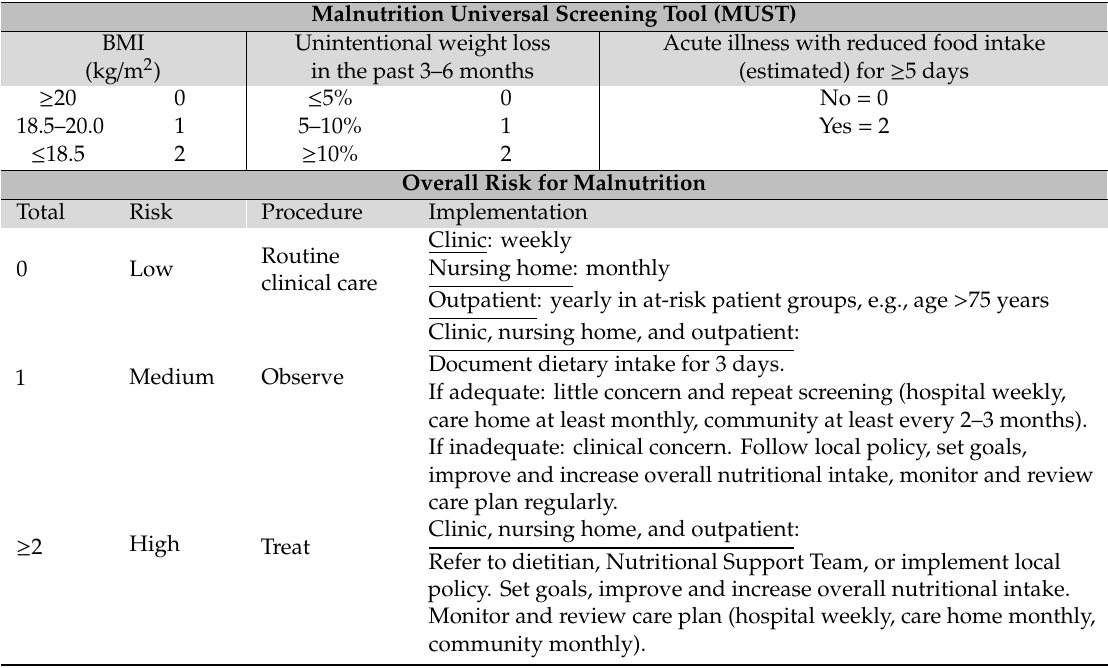
Table 3. The Mini Nutritional Assessment Short-Form.